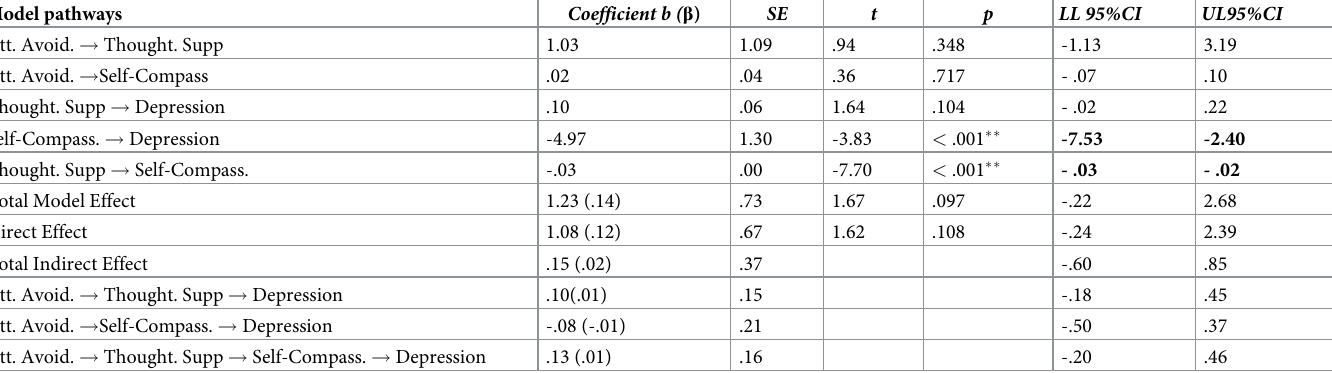
Table 2. Serial mediation effects of thought suppression and self-compassion on the relationship between attachment avoidance and depression whilst controlling for attachment anxiety (Model A). Model